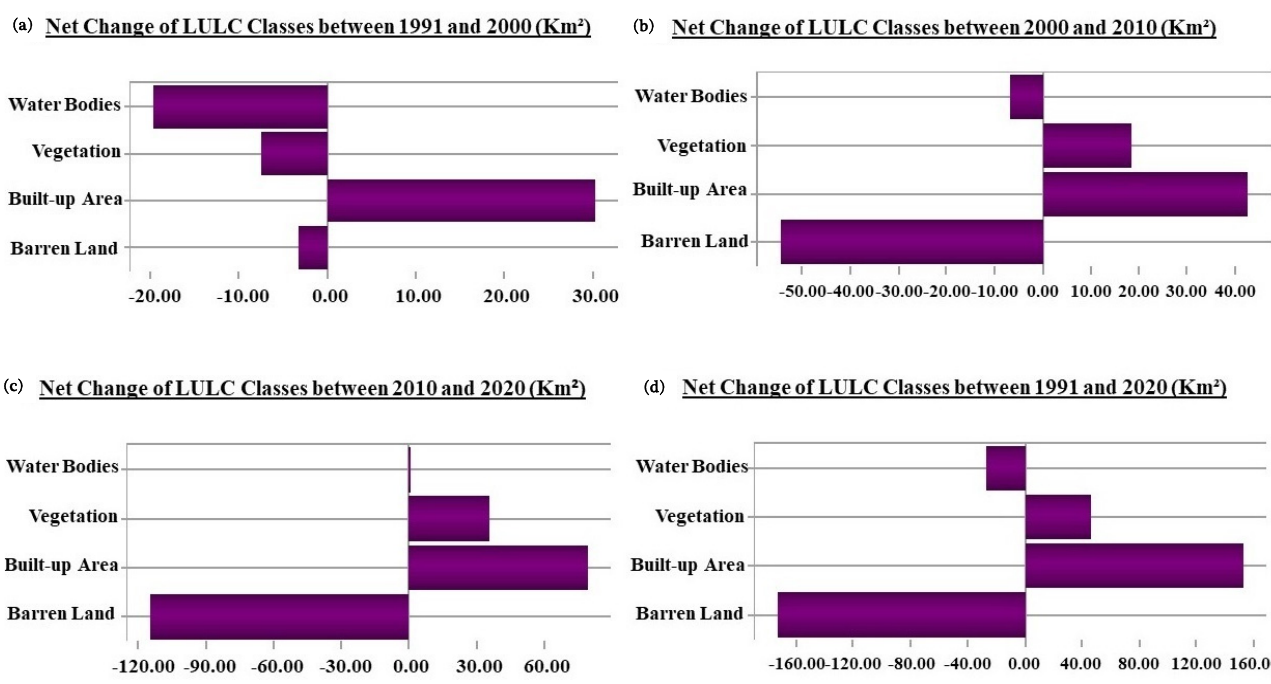
Figure 4. Graphical distribution of LULC in Kano metropolis, Nigeria.